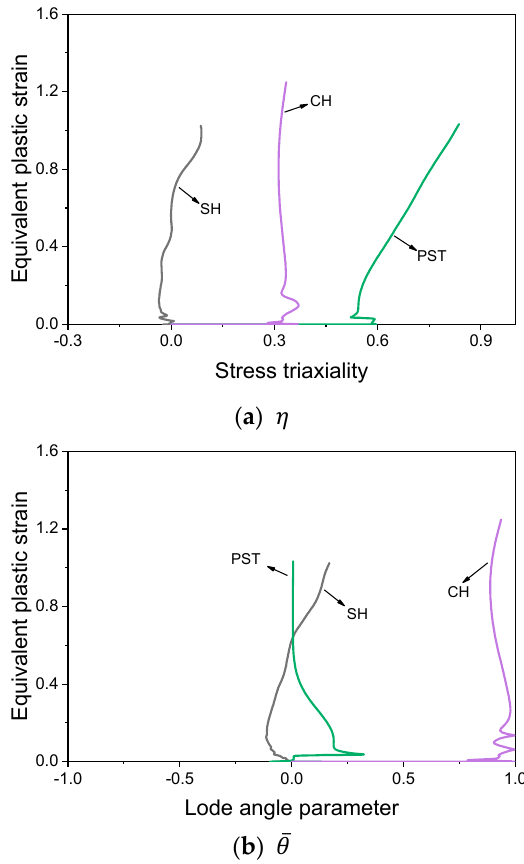
Figure 9. Variation of stress state parameters as function of equivalent plastic strain.